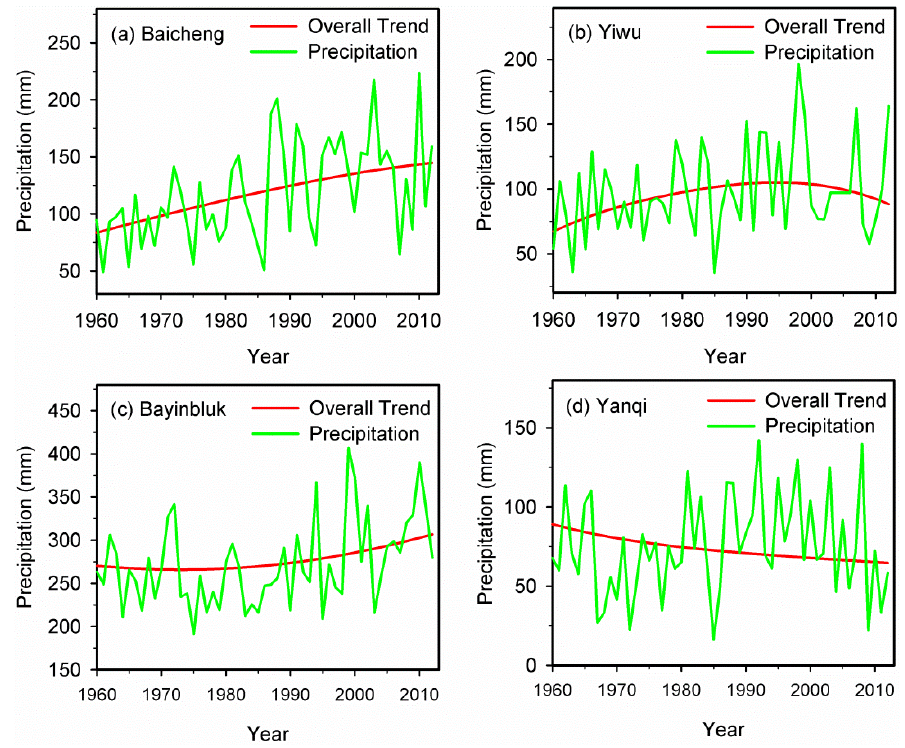
Figure 8. Types of precipitation variation trends in selected typical meteorological stations. ( a ) Baicheng; ( b ) Yiwu; ( c ) Bayinbluk; ( d ) Yanqi.